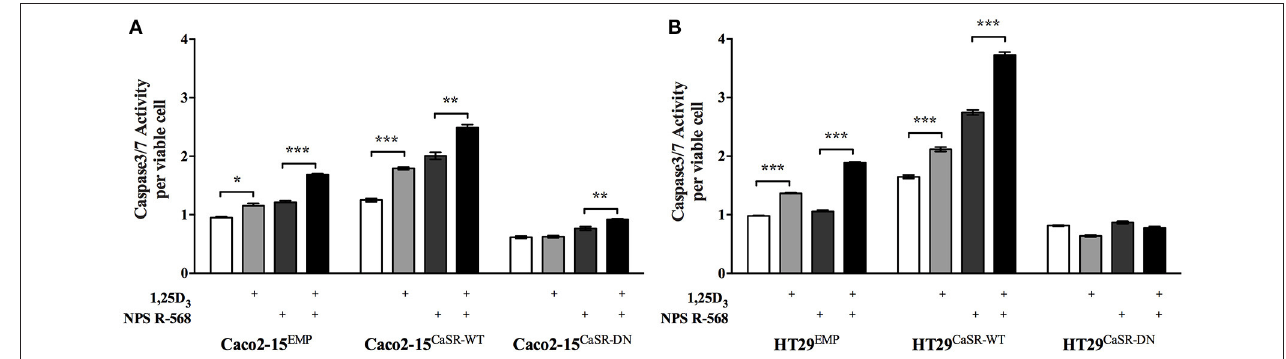
FIGURE 1 | Impact of the inactivating CaSR mutation on the apoptotic effect of 1,25D 3 and NPS R-568 in the colon cancer cell lines Caco2-15 (A) and HT29 (B), stably transfected with wild type (CaSR-WT) or the dominant negative R185Q mutant (CaSR-DN). Cells transfected with and empty vector (EMP) were used as controls. One week post confluence, the cells were treated with 1,25D 3 (1nM), NPS R-568 (1 µ M) or a combination of 1,25D 3 and NPS R-568 for 48h. Apoptosis was assessed by measuring caspase3/7 activity. Bars represent mean ± SEM . Statistical significance was calculated using two-way ANOVA followed by Tukey’s correction. * p < 0.05, ** p < 0.01, *** p < 0.001. Modified from Aggarwal et al. (2016).